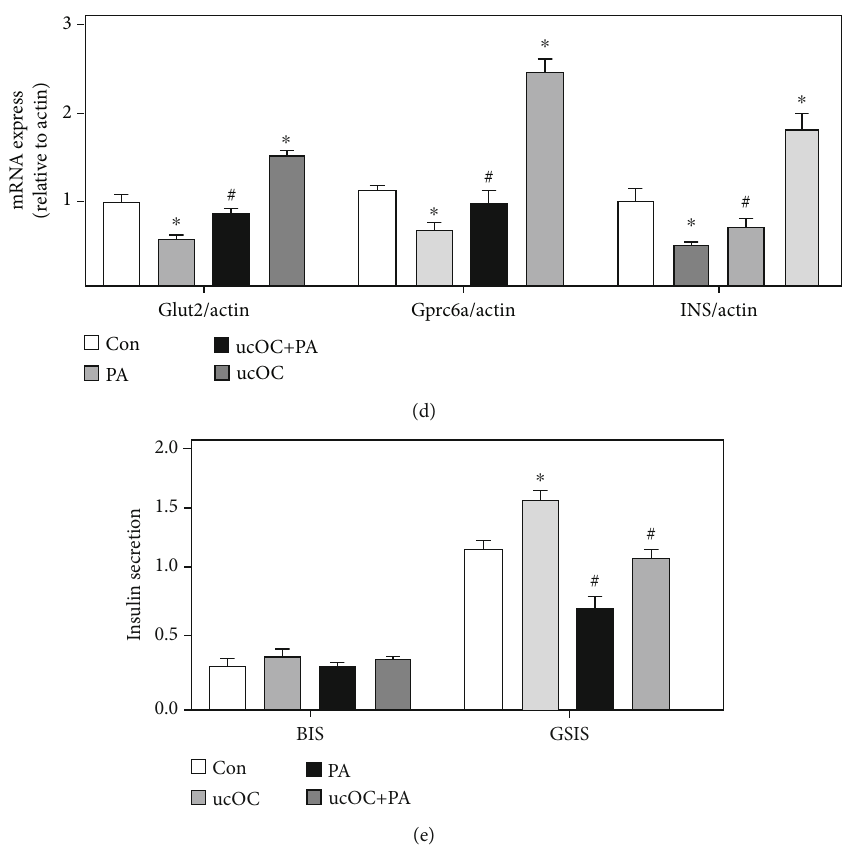
Figure 5: ucOC suppressed the lipotoxic islet β -cell damage caused by PA. (a) The protein expression of Gprc6a, Glut2, AKT, FOXO1, and Pdx1 was measured through western blotting after treatment with PA or ucOC. (b) The protein expression of Gprc6a and Glut2 was analyzed. (c) The protein expression of AKT and FOXO1 was analyzed. (d) The mRNA expression of Gprc6a and Glut2 was measured through qRT-PCR. (e) The insulin secretion was analyzed. Compared with the control group, ∗ P < 0 : 05 . Compared with the PA group, # P < 0 : 05 . Beta-TC6 was used in these CTGCCTGAC-3 ′ , R: 5 ′ -AGCACTGTGTTGGCGTACAG-